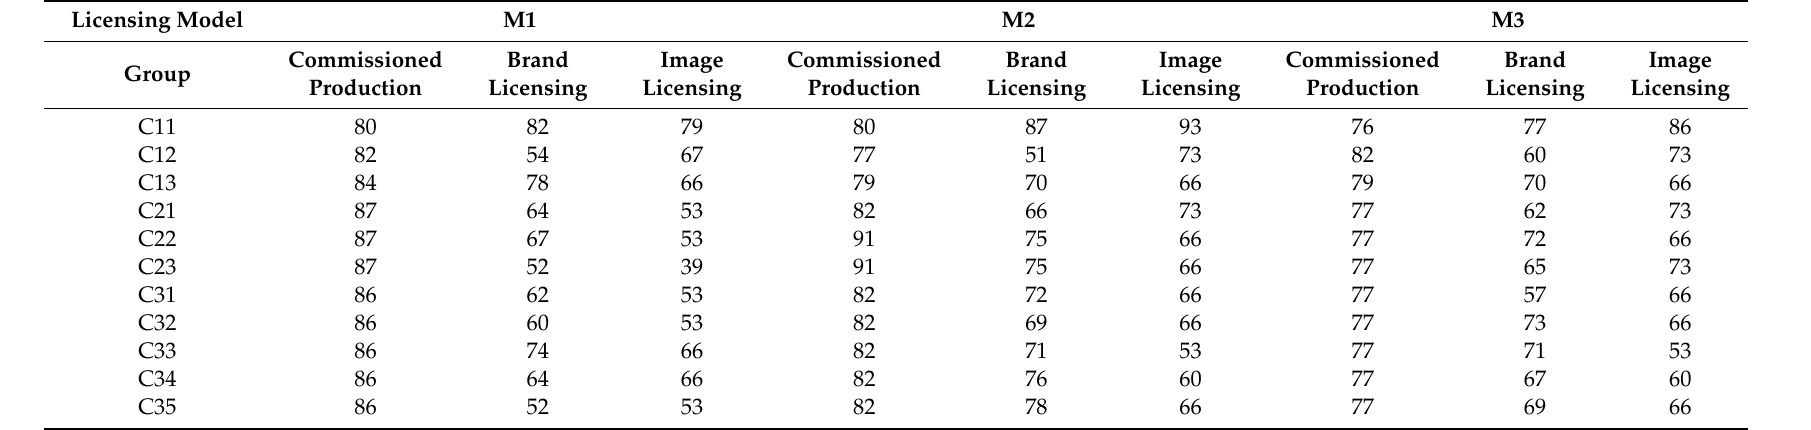
Table 7. Performance values of criteria in three licensing models for each